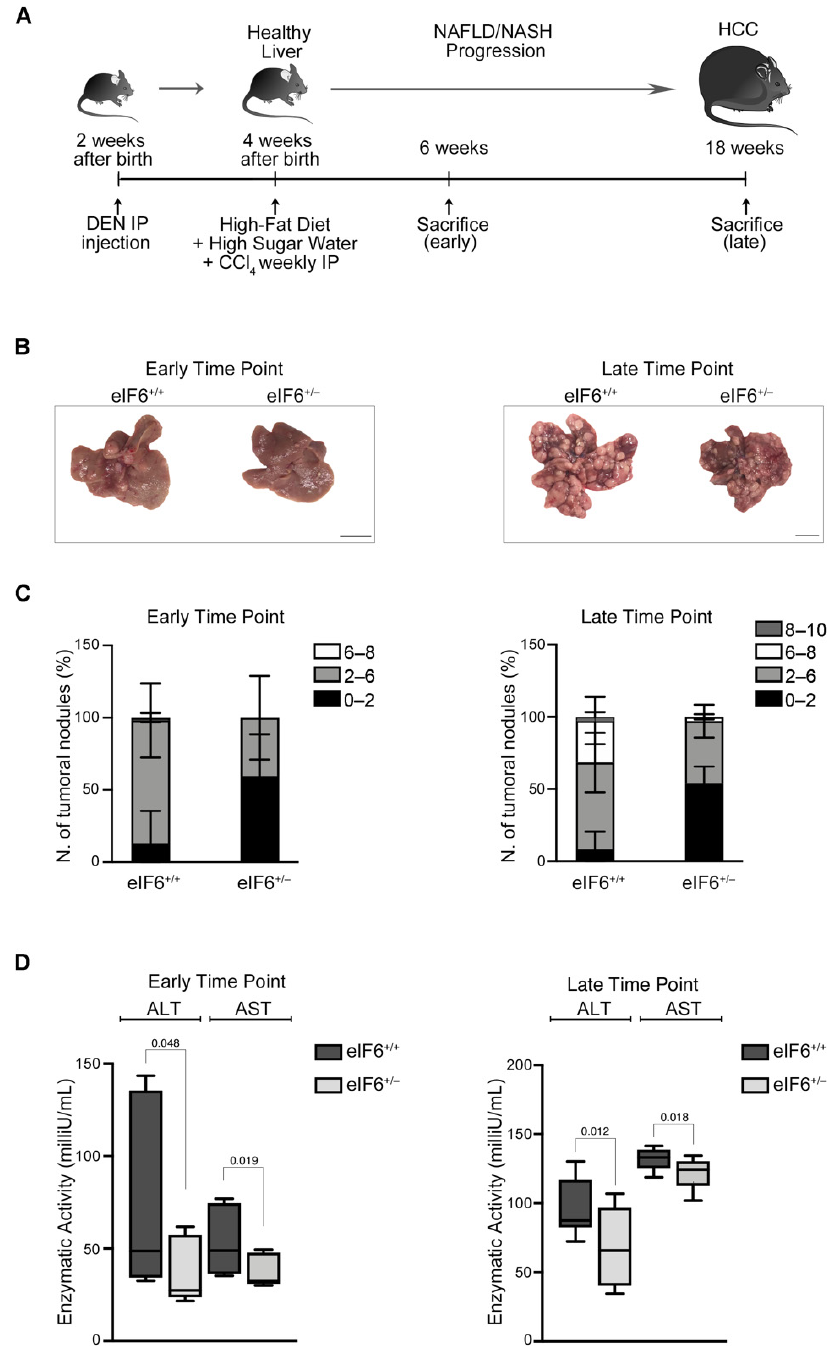
Figure 1. eIF6 haploinsufficiency reduces HCC nodule development and liver injury. ( A ) Schematic overview of NAFLD to HCC mouse model generation. ( B ) Representative images of eIF6 +/+ and eIF6 +/ − livers at two different time points. Scale bar = 1 cm. ( C ) Stacked bar charts representing the quantification of total surface tumors classified into four size ranges. Most nodules in eIF6 +/ − livers were in the lower range. Early time point, n = 3 for each genotype; late time point, n = 6 eIF6 +/+ mice and n = 4 eIF6 +/ − mice. ( D ) Liver functionality evaluation: AST and ALT enzymatic activities were measured at the early (left) and late (right) time points. Data are represented as box-plots for n = 3 (early time point) and n = 4 (late time point) mice for each genotype. The bold black line indicates the median and the whiskers show the range from the minimum to maximum value. The results of two-tailed t tests are shown on each